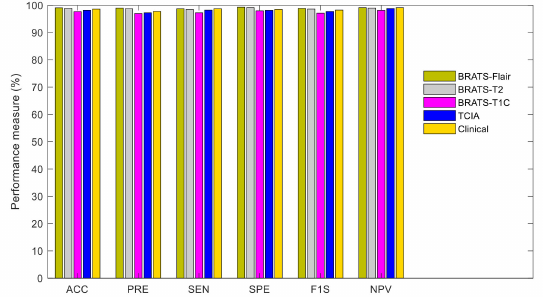
Figure 7. Graphical representation of the performance measures attained with customized VGG19.